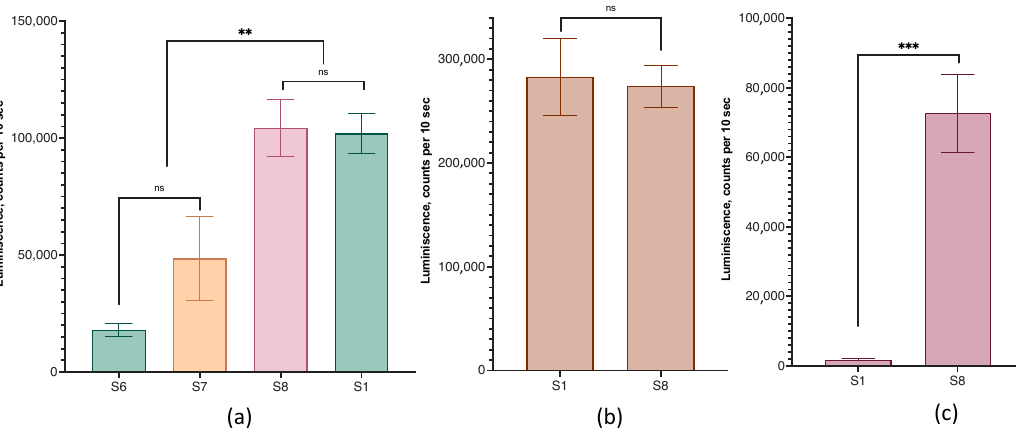
Figure 12. The efficiency of cell transfection with lipoplexes prepared from LNPs with GM3 gangliosides. Ganglioside content: 0.5% (sample S6), 1% (sample S7), and 1.7% (sample S8); control—sample S1 (Table 1). Incubation time was 24 h. ( a ) HEK 293T cells, ( b ) MDA-MB-231 cells, ( c ) SW 620 cells. ns—not significant. ns. not significant, n = 3.